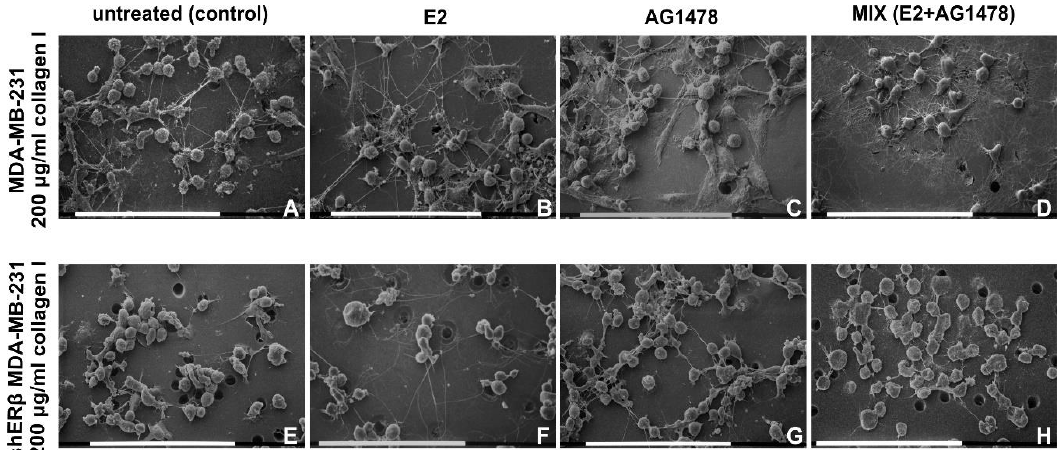
Figure 3. MDA-MB-231 and shERβ MDA-MB-231 cells cultured on Millipore filter covered by 200 µg/mL type I collagen. ( A ) Untreated MDA-MB-231 globular-shaped cells are grouped in clusters of a few cells showing long, thin filopodia and tunneling nanotubes (TNTs). ( B ) Most of MDA-MB-231 cells treated with E2 show a globular shape, but elongated-fusiform and flattened-polygonal cells are also observable. ( C ) Thin long filopodia are present similarly to untreated cells, but TNTs seem more numerous vs. control group MDA-MB-231 cells treated with AG1478 include globular, elongated-fusiform but a higher number of flattened-polygonal-shaped cells vs. control and E2 treated groups. Thin, long filopodia and TNTs are still detectable. ( D ) After both E2 and AG1478 treatment (mix group) MDA-MB-231 cells show globular, flattened-polygonal and few elongated-fusiform phenotypes. TNTs and many long, thin filopodia adhering to the collagen substrate and radially arising from cells give the cells a “spider” aspect. ( E ) Untreated shER β MDA-MB-231 mainly includes smooth globular cells grouped in tight contact and showing short thin filopodia and few TNTs. ( F ) The same cells treated with E2 still exhibit a globular shape but appear in isolated groups of two or three cells showing longer filopodia vs. untreated control group. ( G ) After AG1478 treatment, the shER β MDA-MB-231 globular-shaped cells again look grouped and show more contact one to each other. Fewer short and thin filopodia and intercellular TNTs are present. ( H ) After the combined treatment of E2 and AG1478, shER β MDA-MB-231 cells look relatively grouped, displaying the same globular shape and show few short filopodia and TNTs. Bar = 0.1